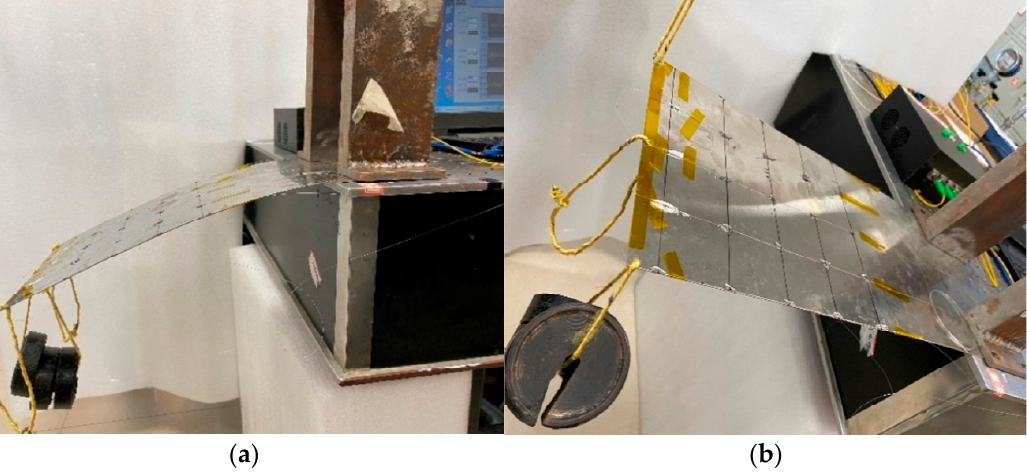
Figure 10. Load loading method of the structural specimen: ( a ) Hanging mass block at middle loading point; ( b ) different loads on both sides loading points.